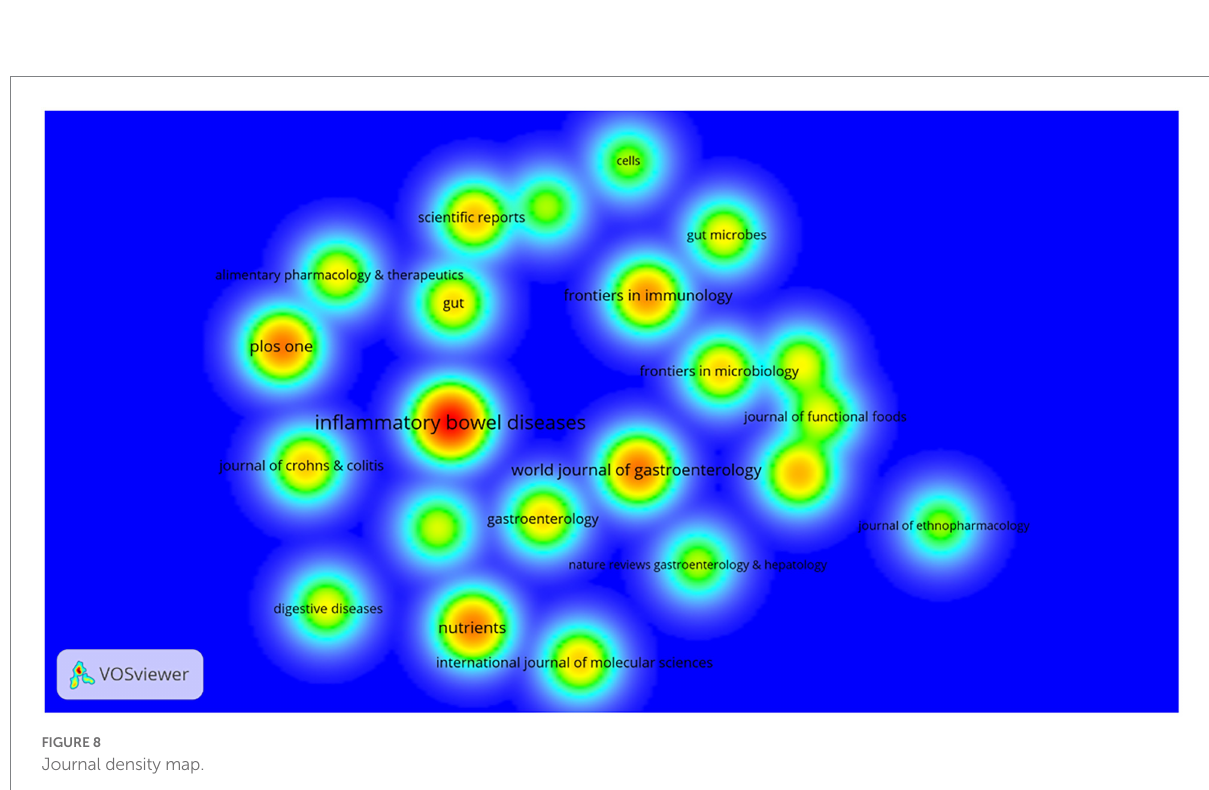
FIGURE 8 Journal density